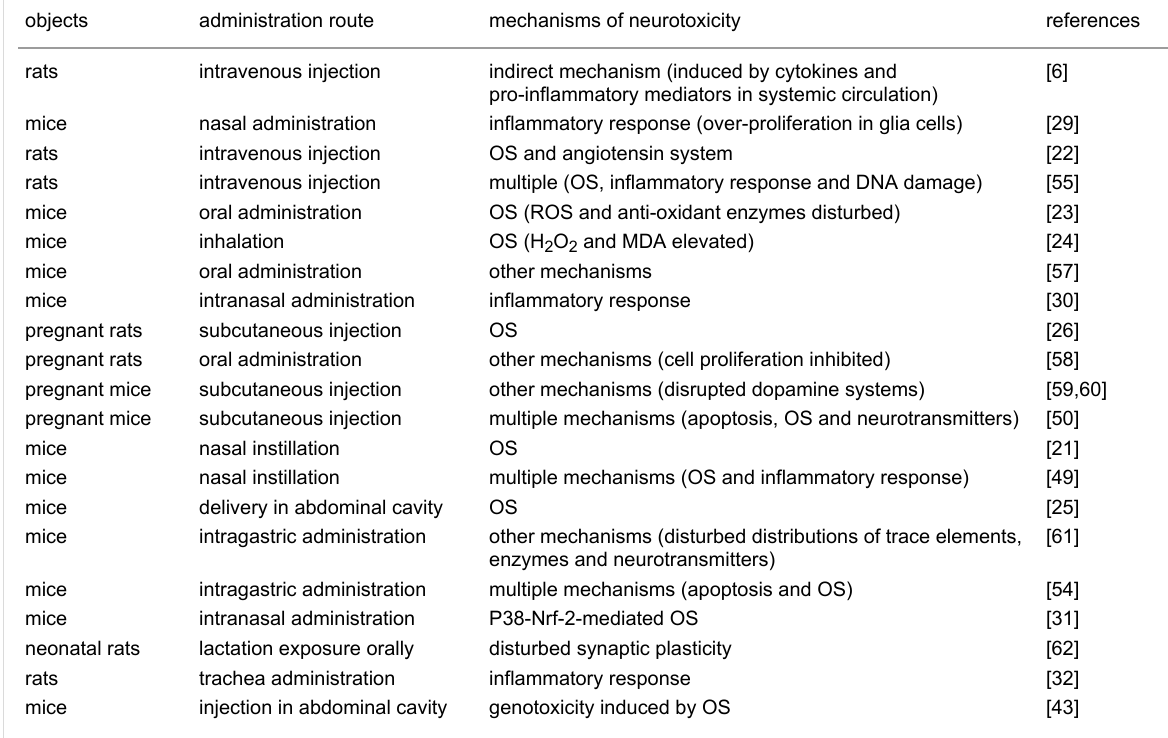
Table 1: Mechanisms of neurotoxicity of titanium dioxide nanoparticles in in vivo studies.